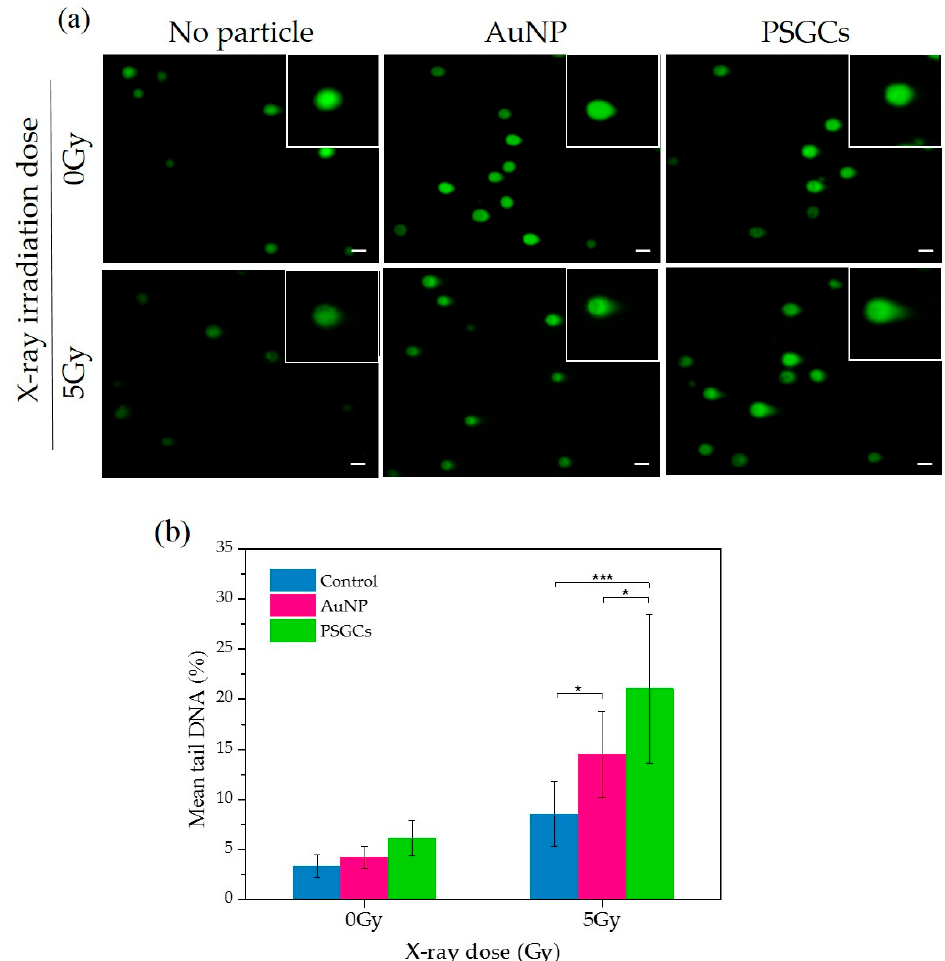
Figure 6. ( a ) Evaluation of effectiveness X-ray-induced PDT via comet assay. Scale bar is 10 µ m. ( b ) The DNA damage was detected by quantifying the mean tail DNA (%) and was plotted against X-ray doses. Statistical significance is denoted as follows: * represents a p value ≤ 0.05 and *** represents a p value ≤ 0.001. NS denotes that a value is not statistically significant.